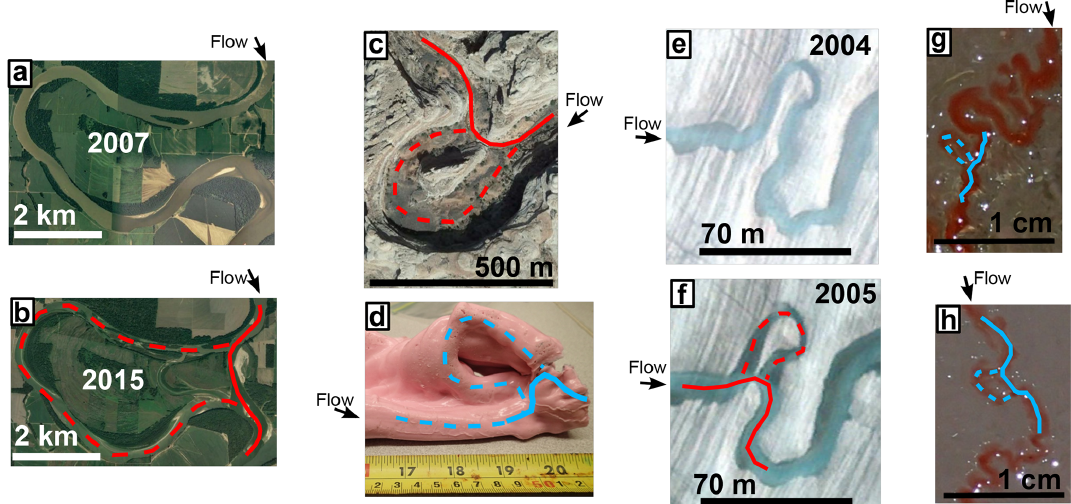
Figure 8. Cutoffs in (a, b) an alluvial river, (c) a bedrock river, (d) a rubber mold of a laboratory melt water channel, (e, f) a supraglacial meltwater stream, and (g, h) self-formed meltwater laboratory channels. Image information: (a, b) chute cutoff in a bend of the Wabash River just upstream of the confluence with the Ohio River; location: 408181.46E, 4186022.16N; source: © Google Earth 2020. (c) Bedrock tributary of the San Juan River; Mogollon Rim, Utah, USA; location: 574447.88E, 4141533.73N; source: © Google Earth 2020. (d) Neck cutoff on rubber mold from a laboratory meltwater channel; source: this study. (e, f) Supraglacial meltwater stream in the Root Glacier, Alaska; location: 399186.46E, 6831268.59N; source: © Google Earth 2020. (g, h) Neck and chute cutoffs on self-formed laboratory meltwater meandering channels; source: this